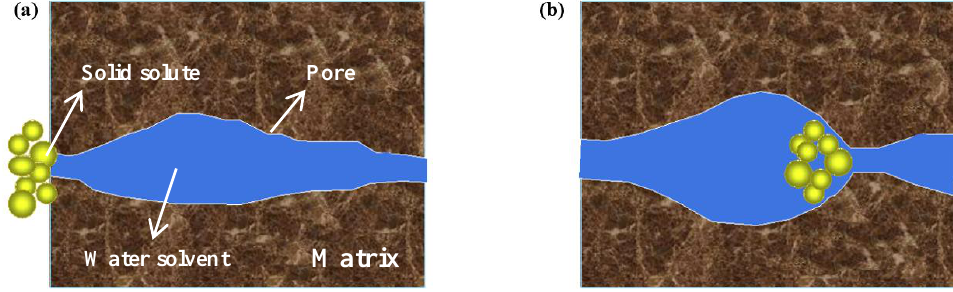
Figure 1. Solid pollution of fracturing water to the underground gas reservoir. ( a ) Filter plugging pollution. ( b ) Matrix plugging pollution.